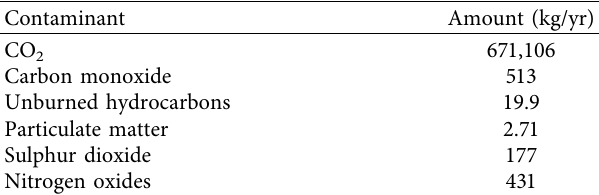
Table 2: Total emissions generated by proposed